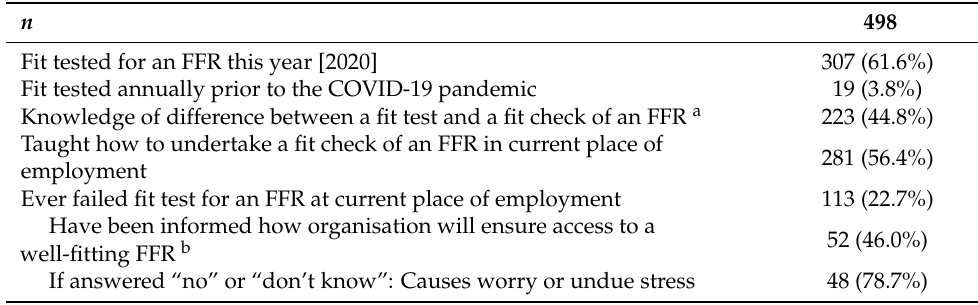
Table 5. Filtering facepiece respirator (FFRs) testing, knowledge and